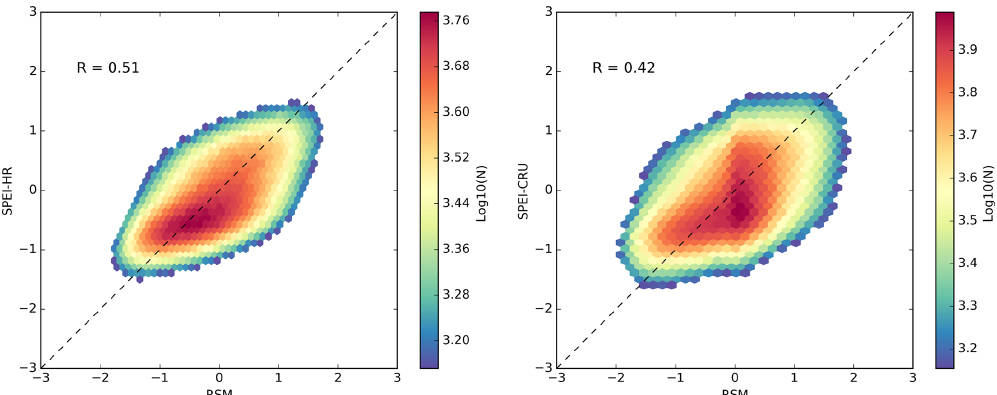
Figure A2. Scatter plots between 6-month SPEI and RSM for the entire data record. R is correlation coefficient with p < 0 . 05, and the colours denote the occurrence frequency of values.